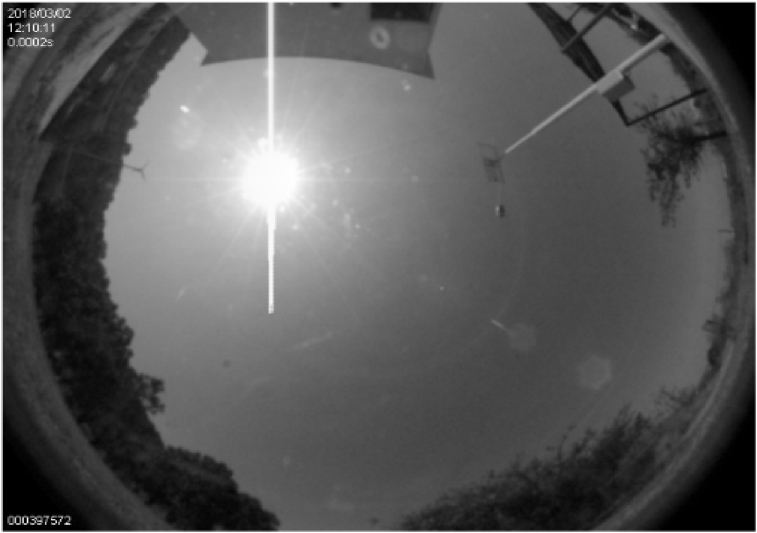
Grayscale image.